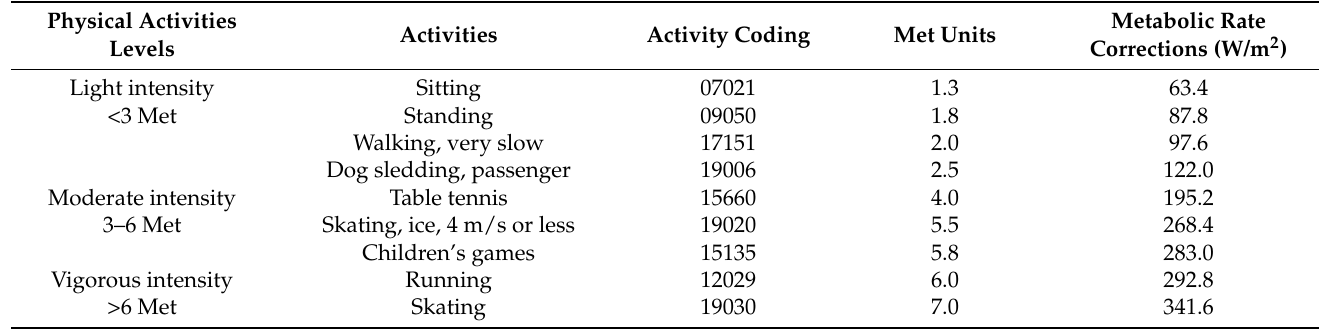
Table 2. Activity types, codes, MET, and modified metabolic value among physical activities intensity